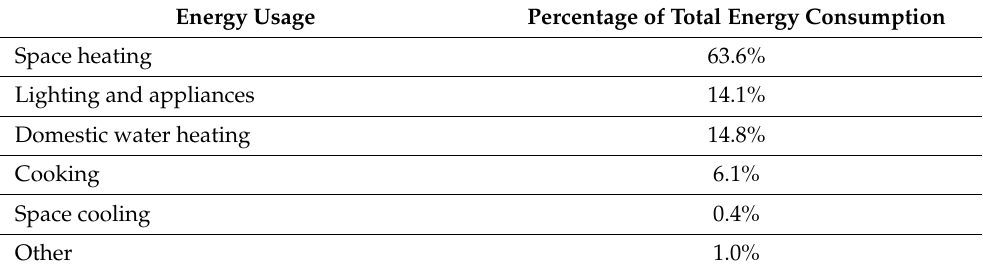
Table 4. Distribution of energy consumption in EU